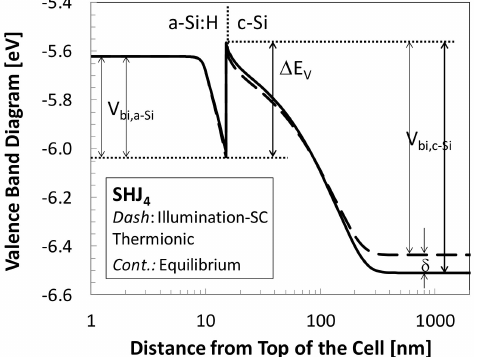
Figure 13. Simulated valence band diagram of cell SHJ 4 at equilibrium and under illumination-SC assuming thermionic emission transport across the hetero-interface with the default A *